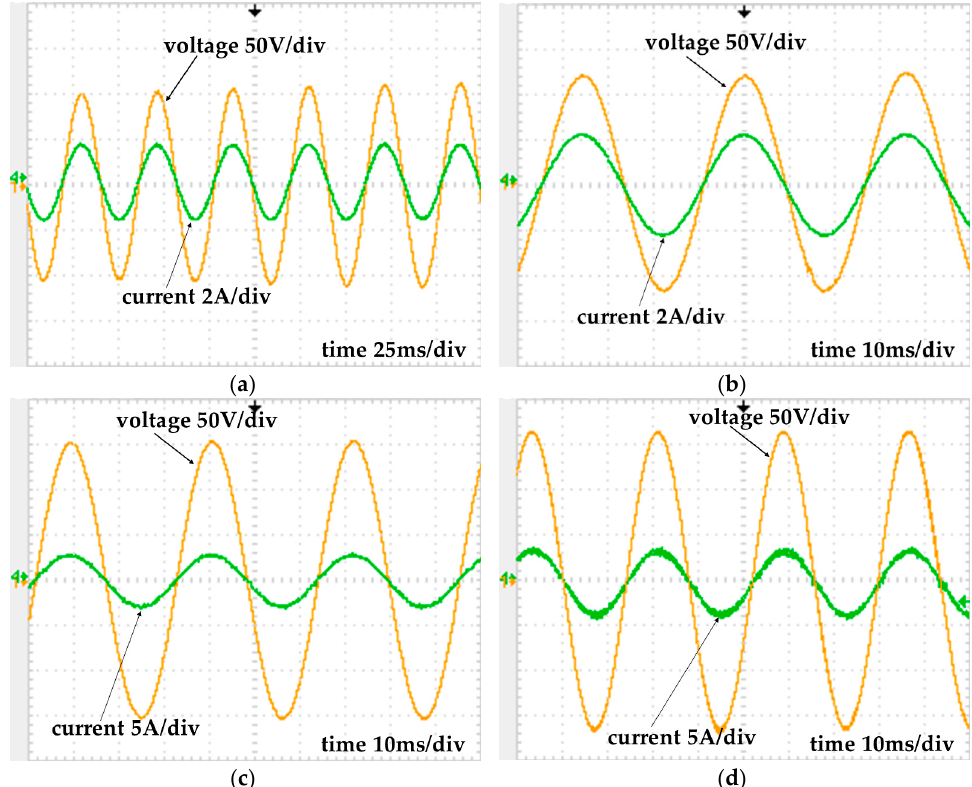
Figure 14. Experimental input voltage and current: ( a ) f = 24 Hz (v wind = 7.2 m/s); ( b ) f = 28 Hz (v wind = 8.4 m/s); ( c ) f = 32 Hz (v wind = 9.6 m/s); ( d ) f = 36 Hz (v wind = 10.8